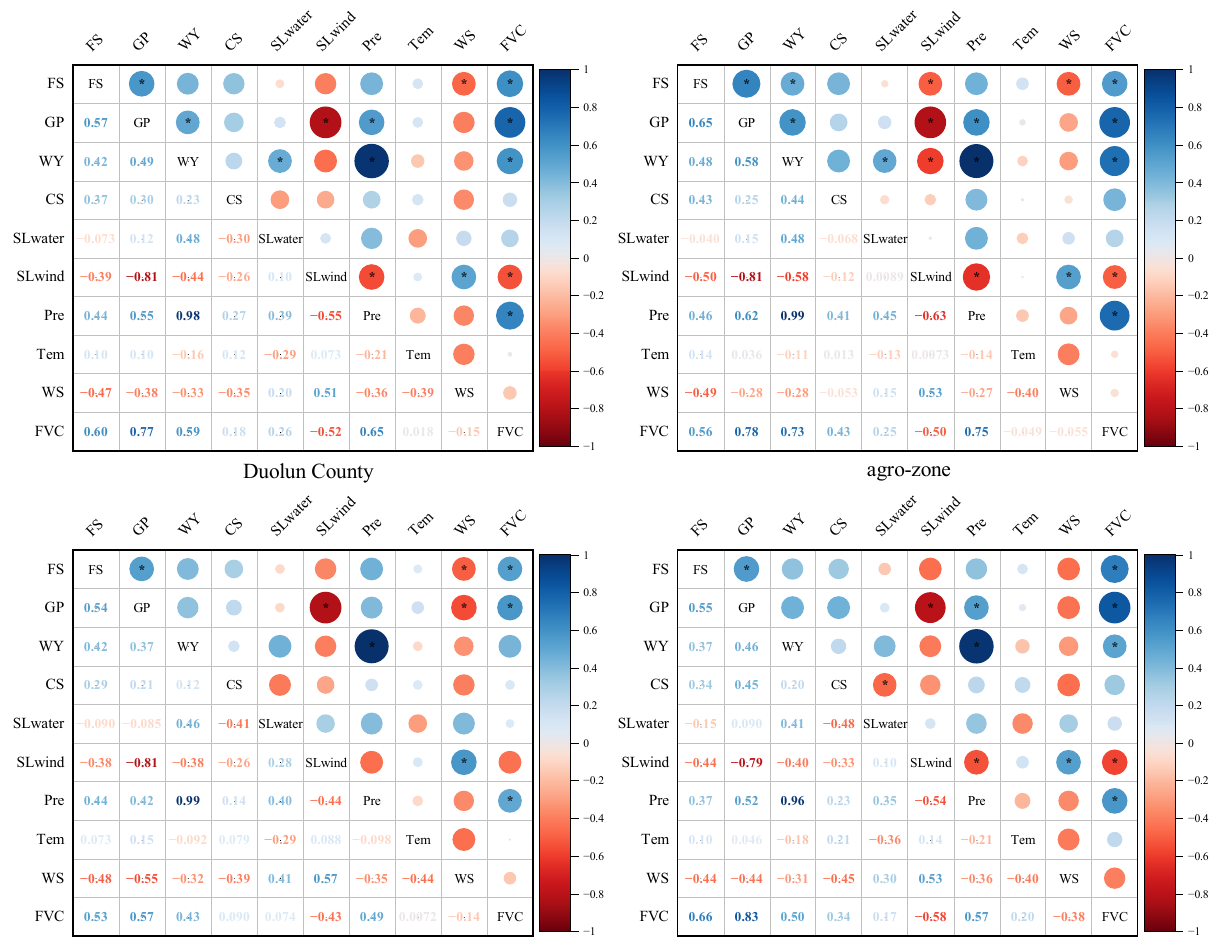
The results showed that (1) Pre, Tem and FVC exhibited a positive correlation with FS and GP, whereas WS exhibited a negative correlation with FS and GP; (2) FVC and Pre were the two drivers that positively affected the changes in WY, whereas Tem and WS showed insignificant inhibitory effects on WY; (3) Pre, Tem and FVC had a positive effect on CS, whereas WS had an inhibitory effect on CS; (4) Pre, WS and FVC mainly showed an insignificant promotion effect on SLwater, whereas Tem showed an inhibitory effect on SLwater; (5) FVC and Pre had suppressive effects on SLwind, whereas Tem and WS had facilitating effects on SLwind.